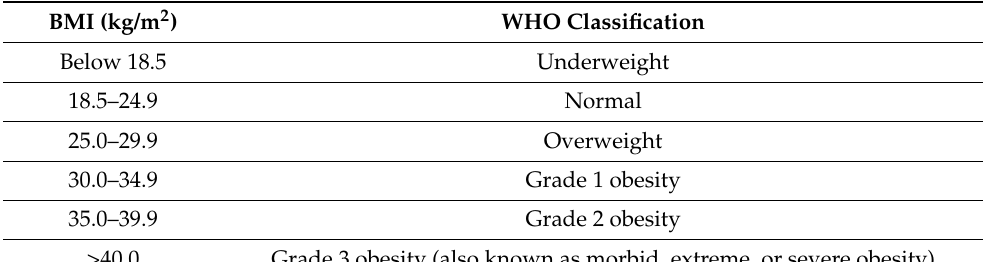
Table 1. WHO classification of obesity based on BMI.